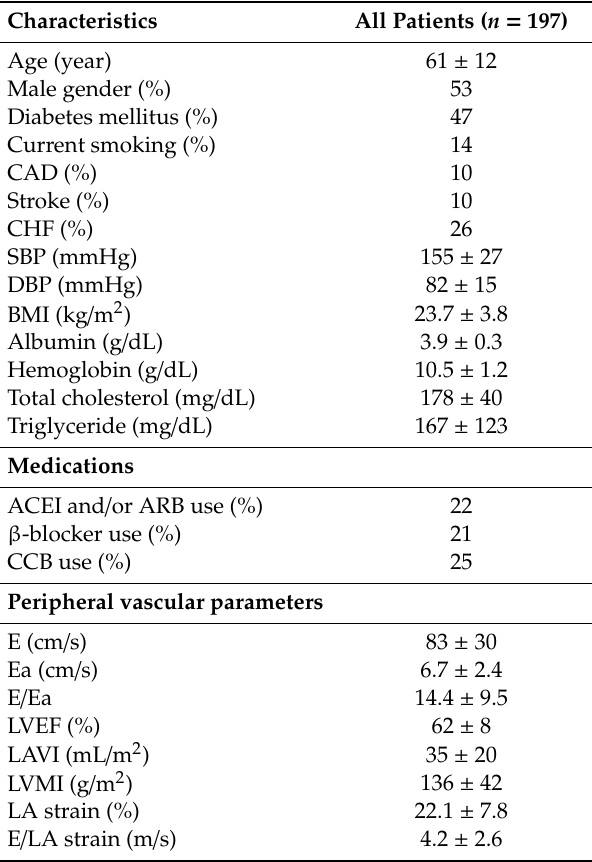
Table 1. Baseline characteristics in our study